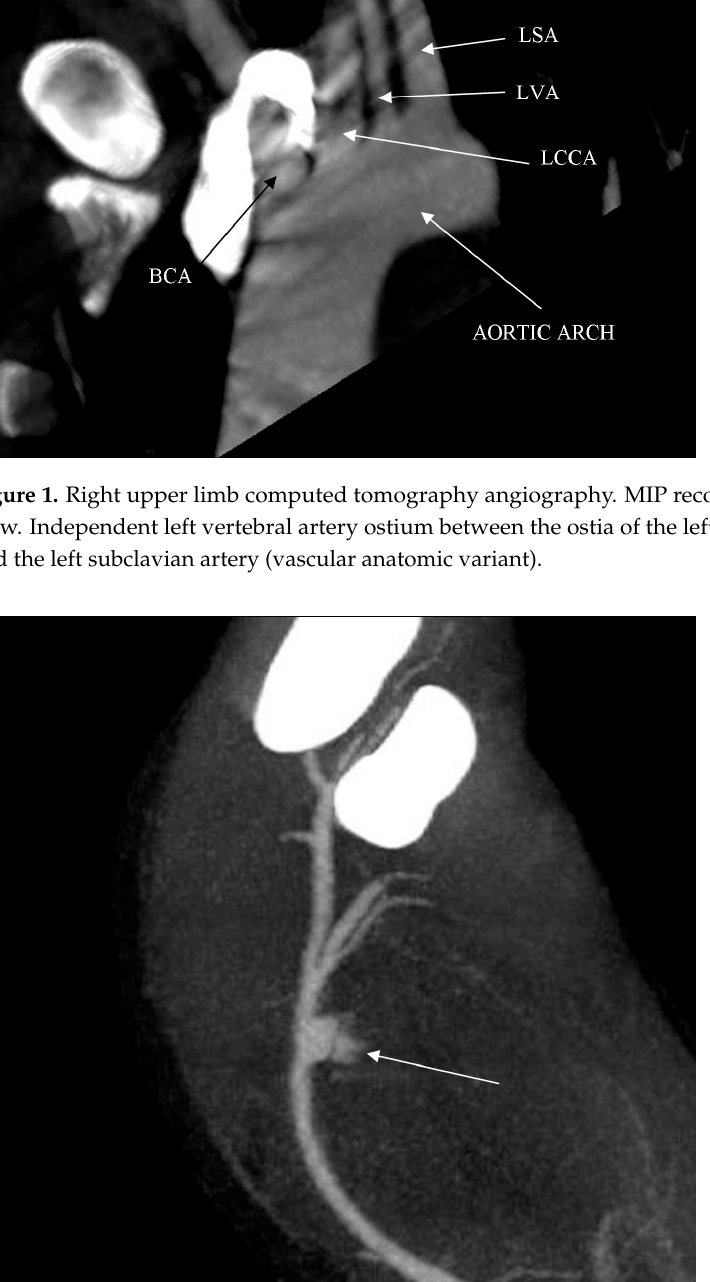
Figure 3. Right upper limb computed tomography angiography. MPR reconstruction. Soft tissue hematoma around the brachial artery: ( A ). Axial view. ( B ). Coronal view.